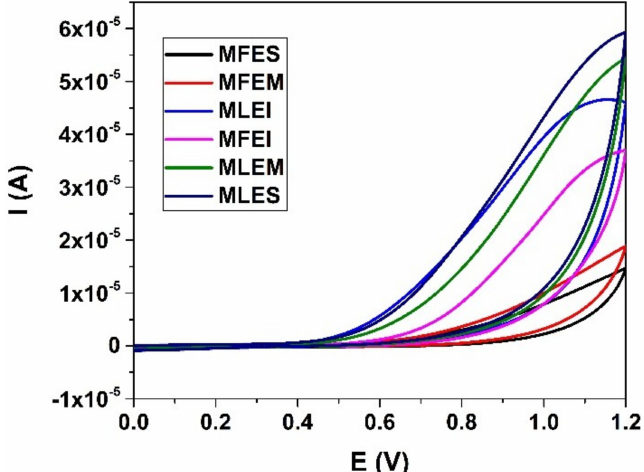
Figure 5. Cyclic voltammograms of samples. Working electrode BDD electrode, PBS at pH 7 as supporting